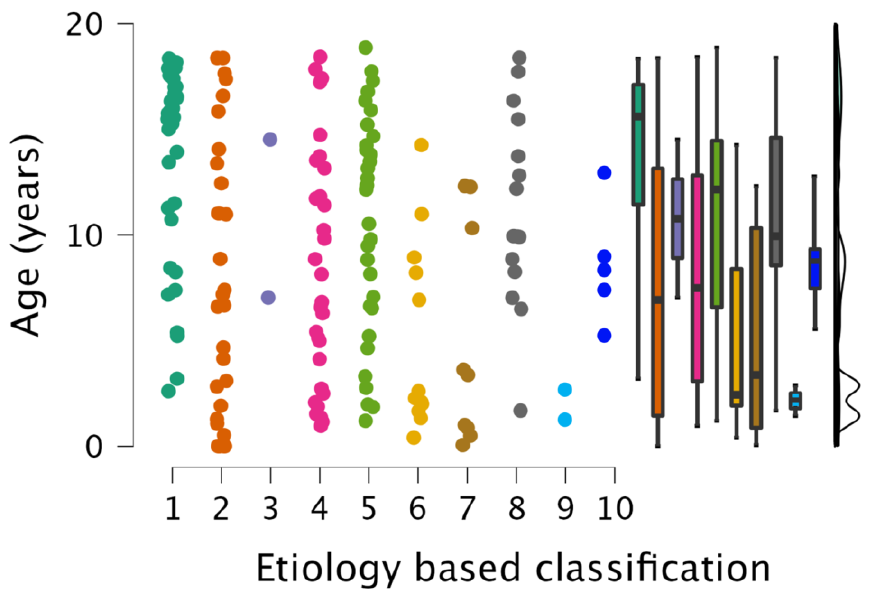
Figure 2. Raincloud plot to visualize the distribution of the data and key summary statistics. The raincloud plot combines a cloud of points with a box plot and a one-sided violin plot.